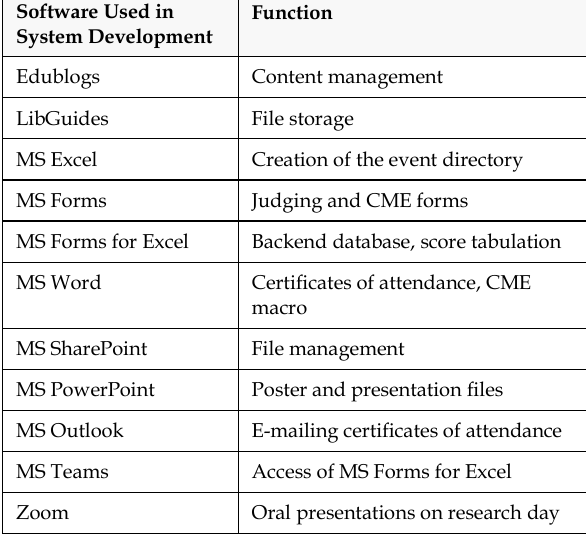
Table 1 Applications Used in the Online Conference